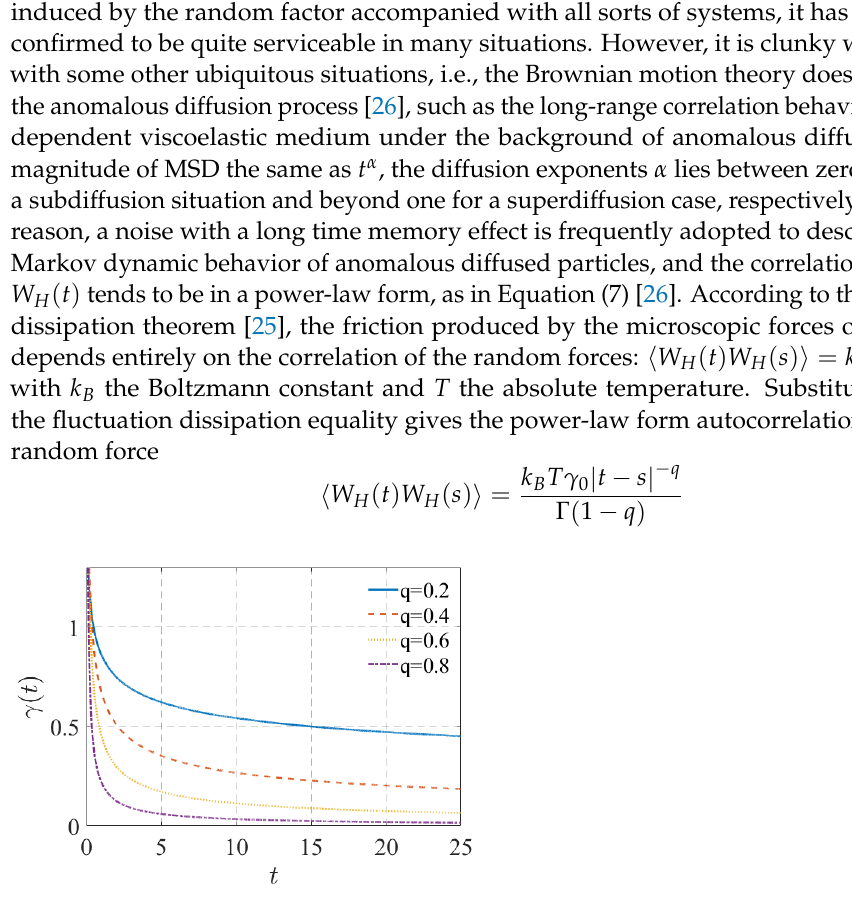
Figure 1. ( Color online ) The shape of damping kernel function γ ( t ) under different q